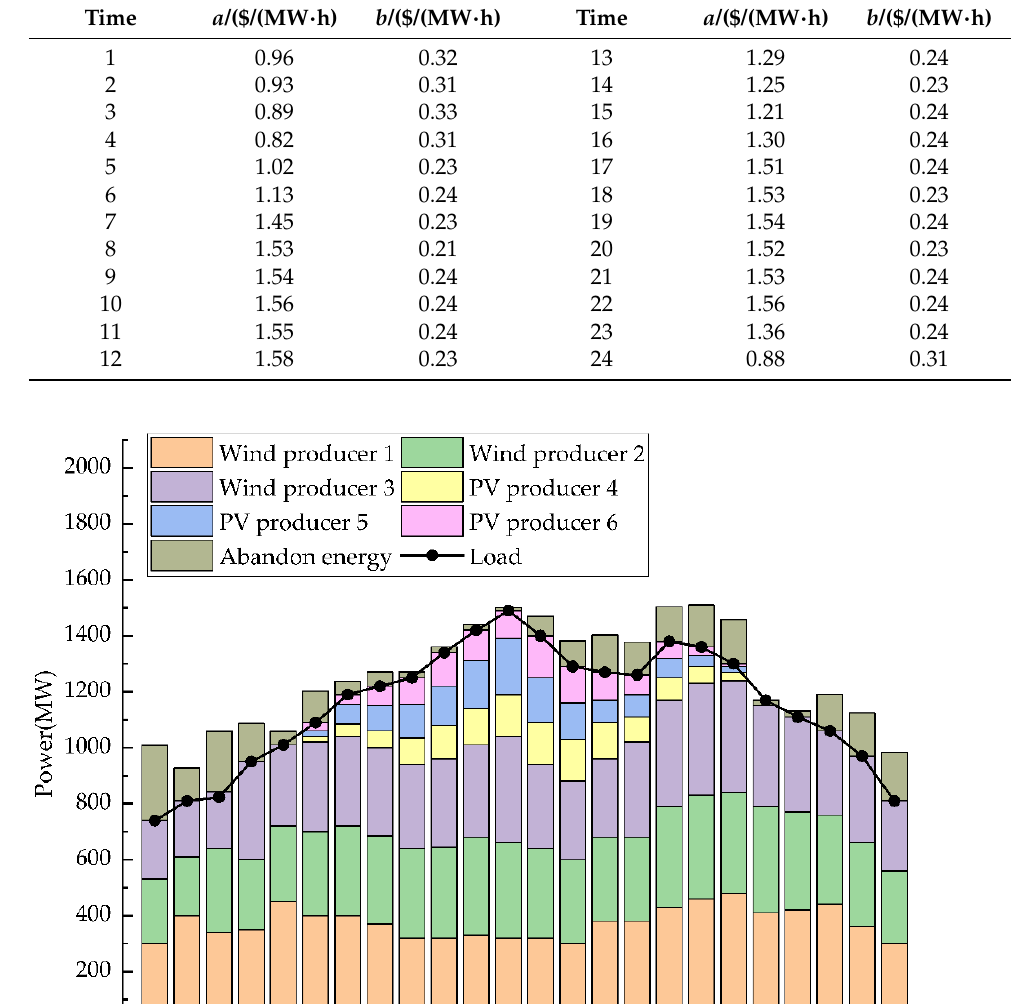
Figure 6. Output of each producer after secondary clearing. The consumption of the three scenarios is shown in Table 3. In Scenario 1, the renew- able energy producer participates in the market clearing at a very low price as a price taker, and theoretically achieves the maximum consumption of renewable energy, with a total of 459 MW·h of curtailment. Renewable energy producers participate in the market as price takers, which has seriously lowered the clearing price of electricity, which is not conducive to the market ’ s discovery of the real price. In Scenario 2, the renewable energy